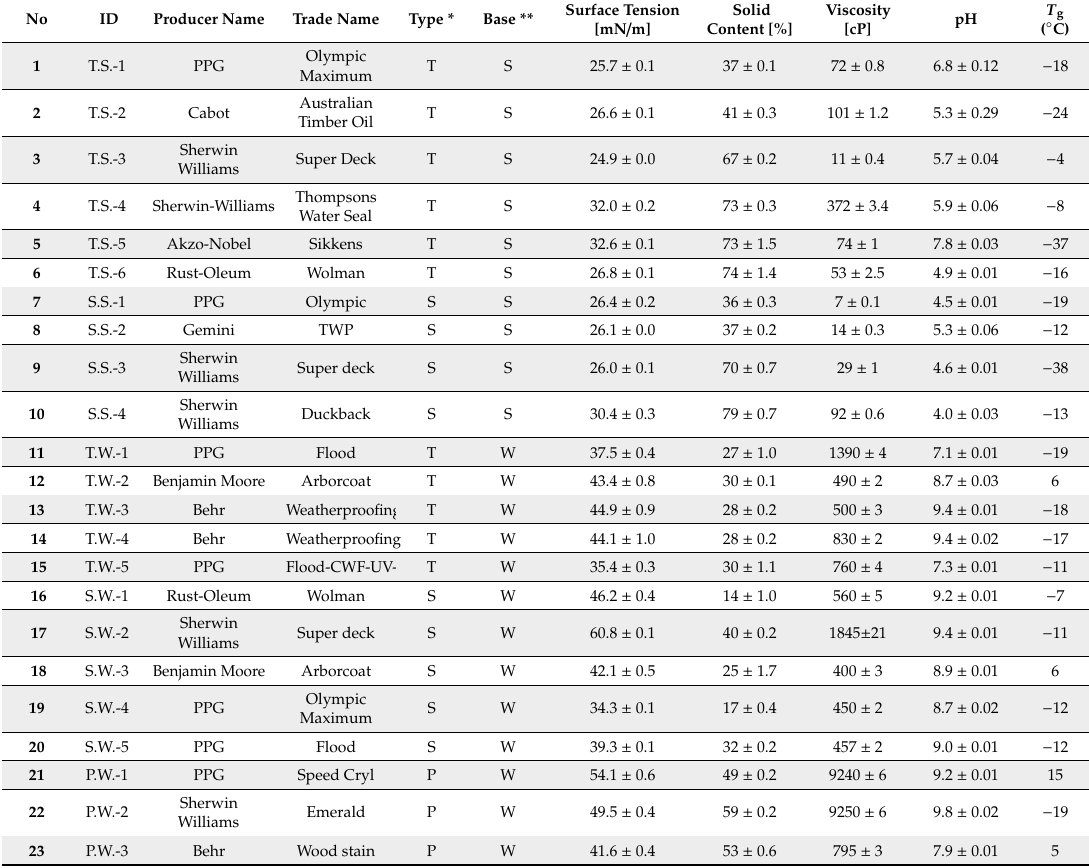
Table 1. List of coatings and their measured